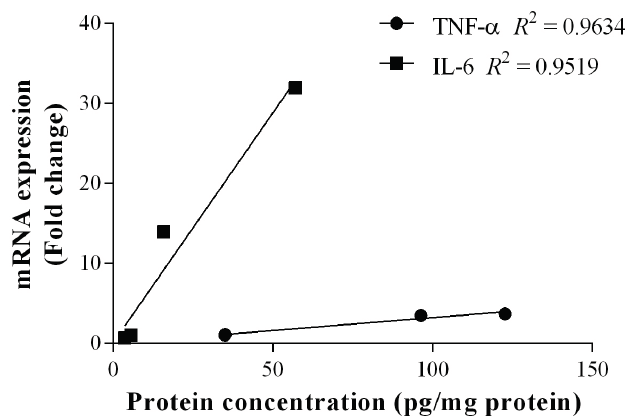
Figure 5. Correlations between proteins and gene expressions of TNF- α and IL-6. Protein concentration of TNF- α was correlated with its mRNA expression, Pearson’s correlation coefficient: r = 0.98, R 2 = 0.96, p < 0.05. Protein concentration of IL-6 was correlated with its mRNA expression, Pearson’s correlation coefficient: r = 0.98, R 2 = 0.95, p <